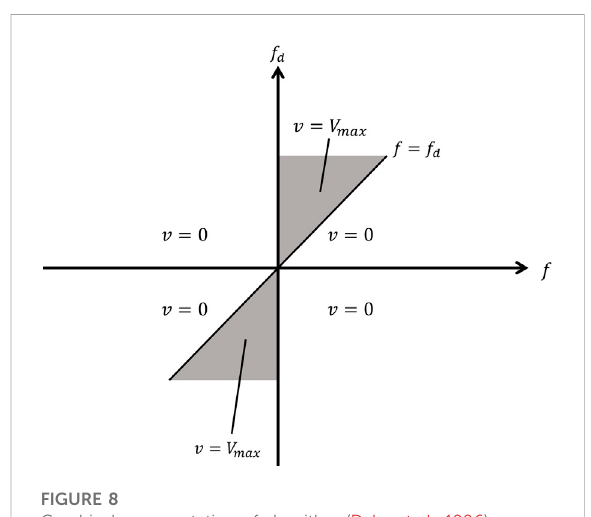
Figure 9. The system controller calculates the desired damping force, and the damper controller serves on the voltage to be applied to the current driver to track the desired damping force.